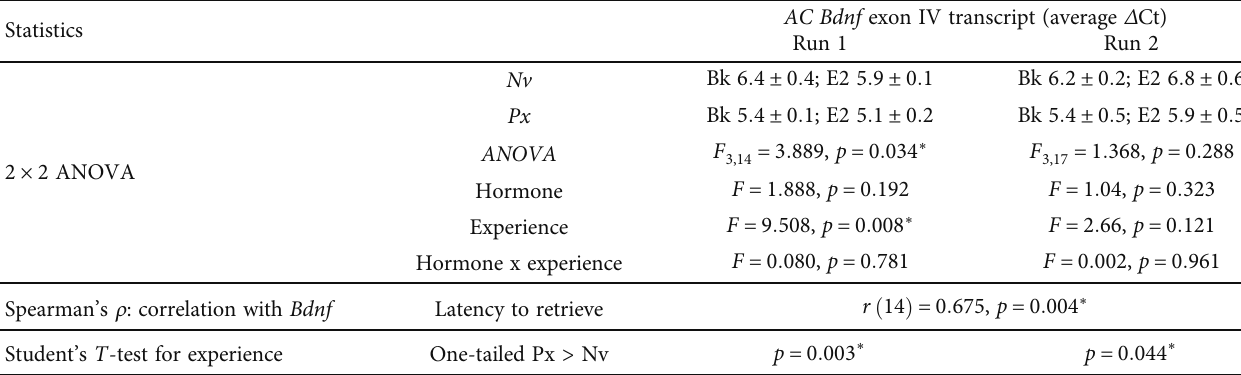
Table 1: Statistical analyses for Bdnf exon IV transcription in AC from two runs with independent samples.